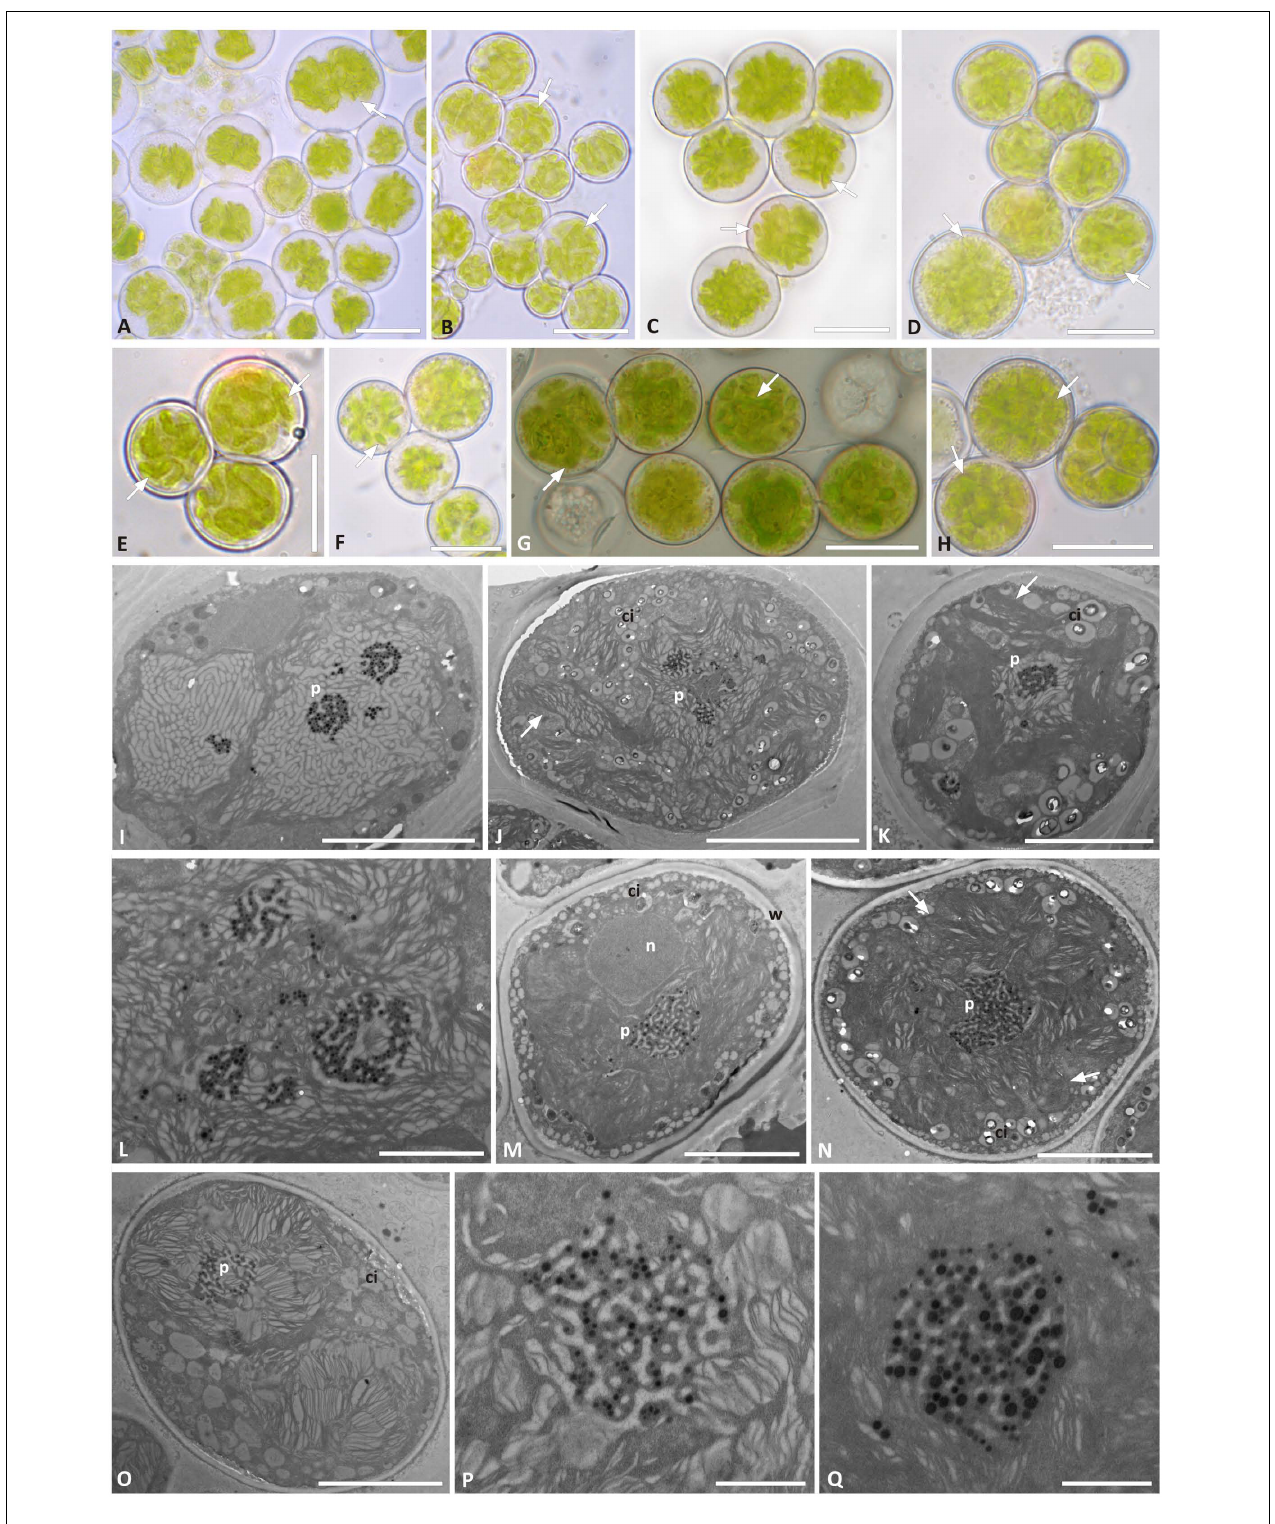
FIGURE 5 | Morphology and pyrenoid ultrastructure of Trebouxia “A02” cells isolated in axenic culture. DNA extraction numbers ( Table 1 and Supplementary Table 2 ) identify the samples as follows: (A–C,E) L3000; (D,H–K) L3015; (F,M–Q) L3202; (G) L3169. (A–H) Algal cells observed by light microscopy; arrows indicate the lobes of the massive central chloroplast. (I–Q) TEM microphotographs: ( I , J , L ) multiple pyrenoid bodies are visible; (P,Q) detail of pyrenoid ultrastructure of gigantea type. The letters indicate cytoplasmic inclusion (ci), pyrenoid (p), and cell wall (w). Scale bars: (A–H,J) 10 µ m; (I,K,M,N) 5 µ m; (L) 2 µ m; (P,Q) 1 µ m.